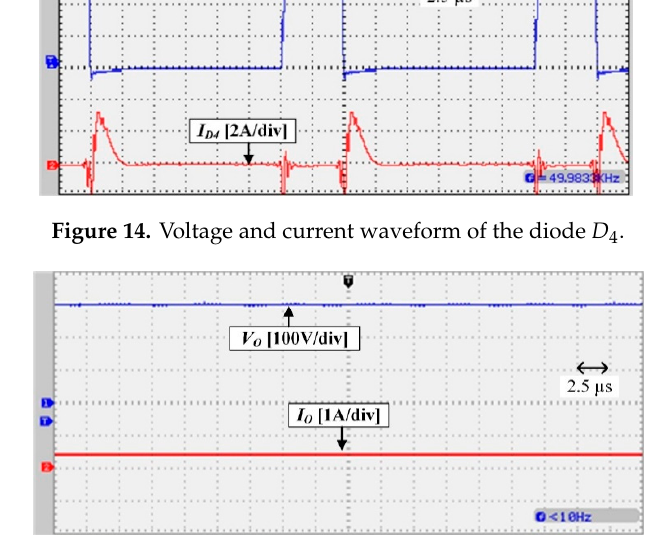
Figure 15. Output voltage and current waveform of the high step-up converter.